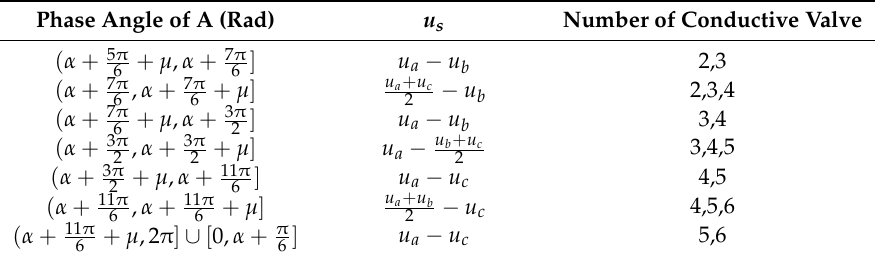
Table 2. Valve voltage of L/C switch equivalent